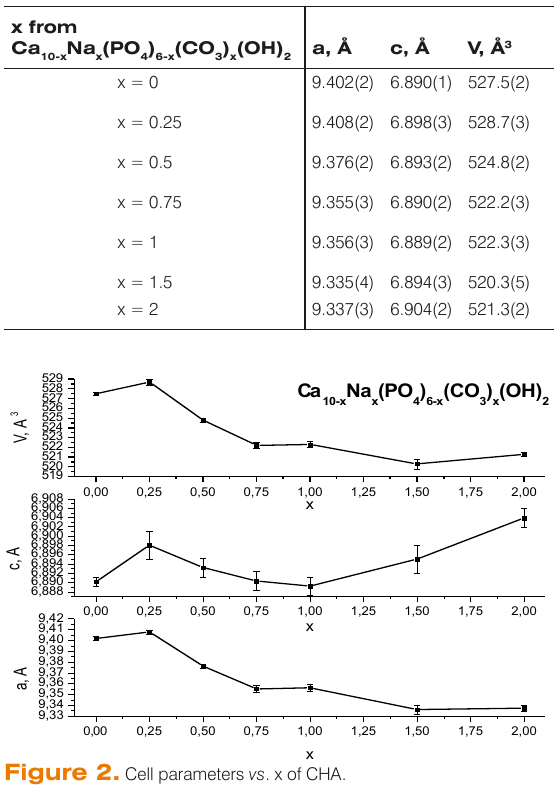
Table 1. Lattice parameters and cell volumes of CHA powders